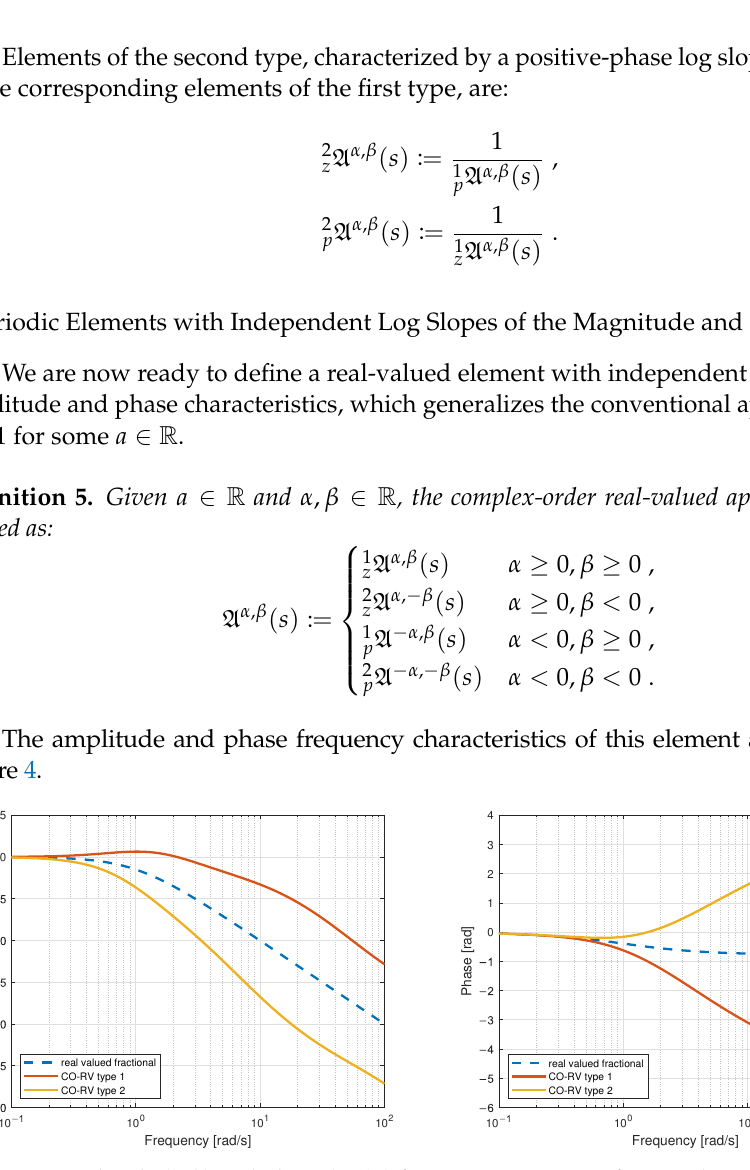
Figure 4. Amplitude ( left ) and phase ( right ) frequency response of a complex-order differentiator with α = 0.5 and β = ±